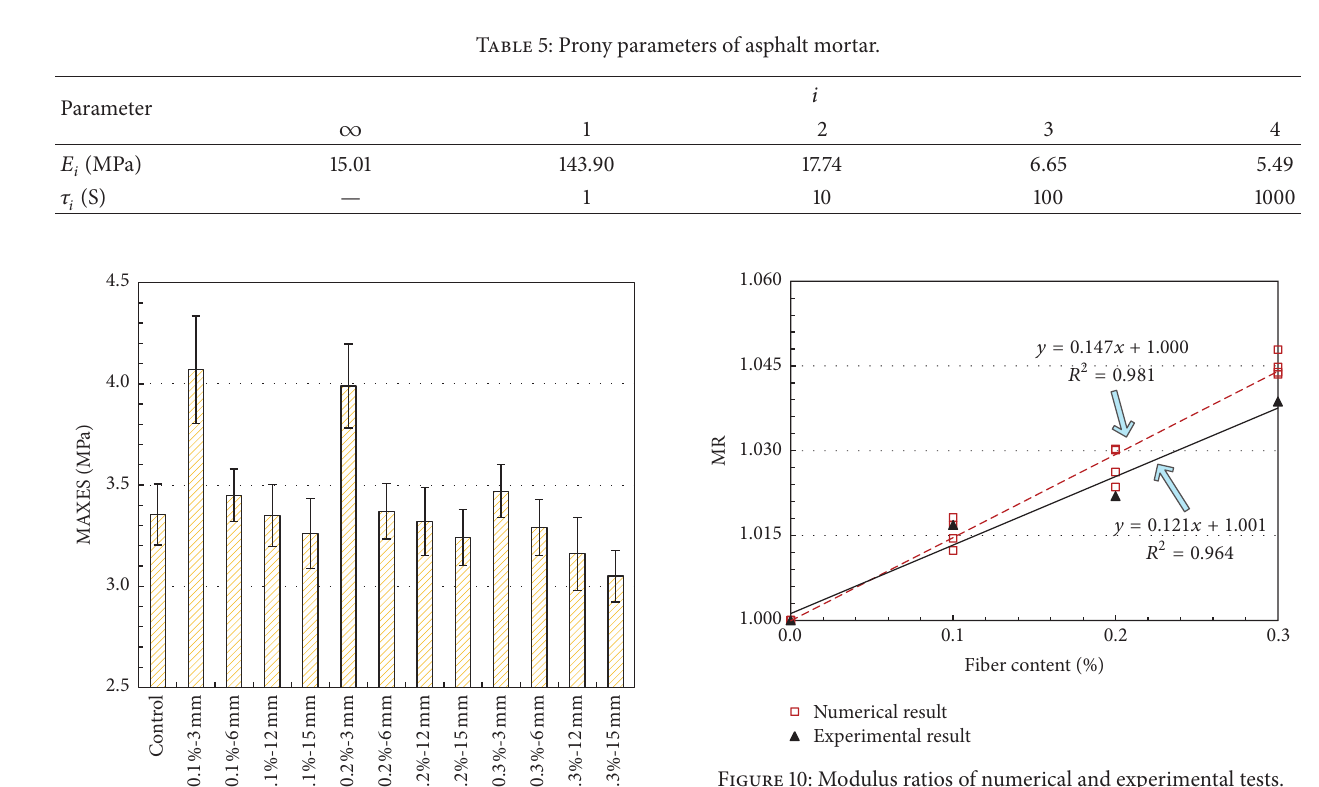
Figure 10: Modulus ratios of numerical and experimental